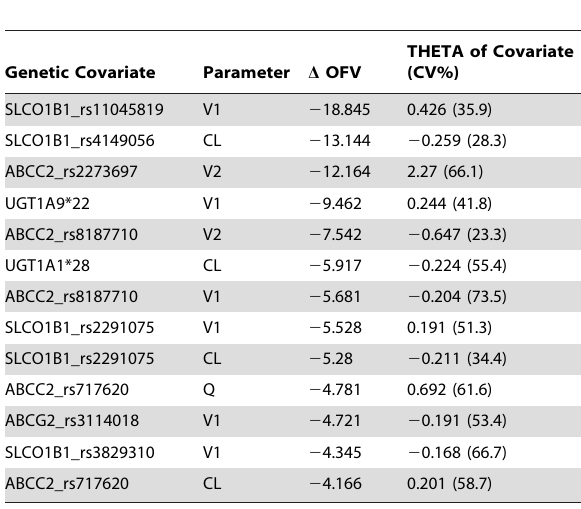
Table 6. Significant covariate-parameter correlations after inclusion of single genetic covariates.